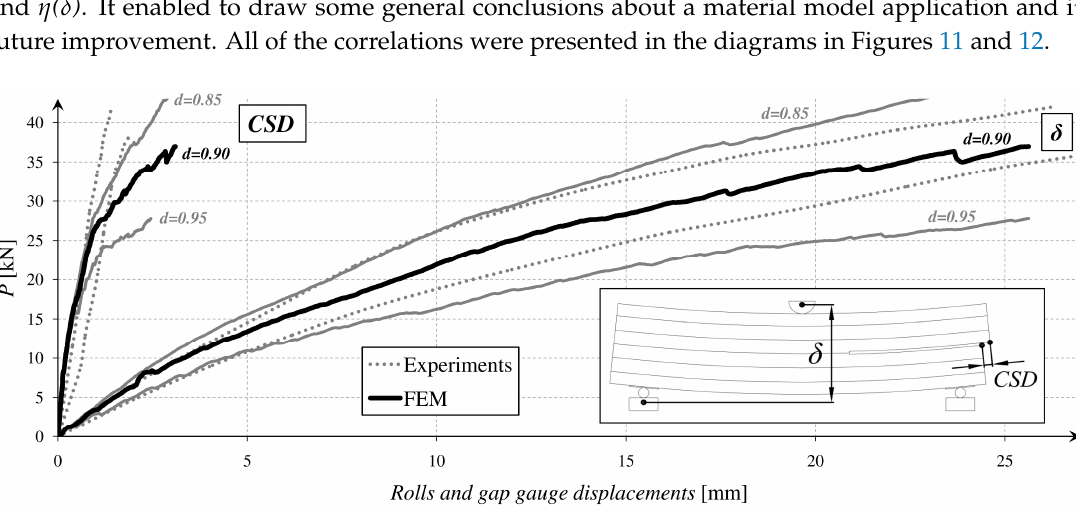
Figure 11. Correlation of the values measured by machine and gap gauge.